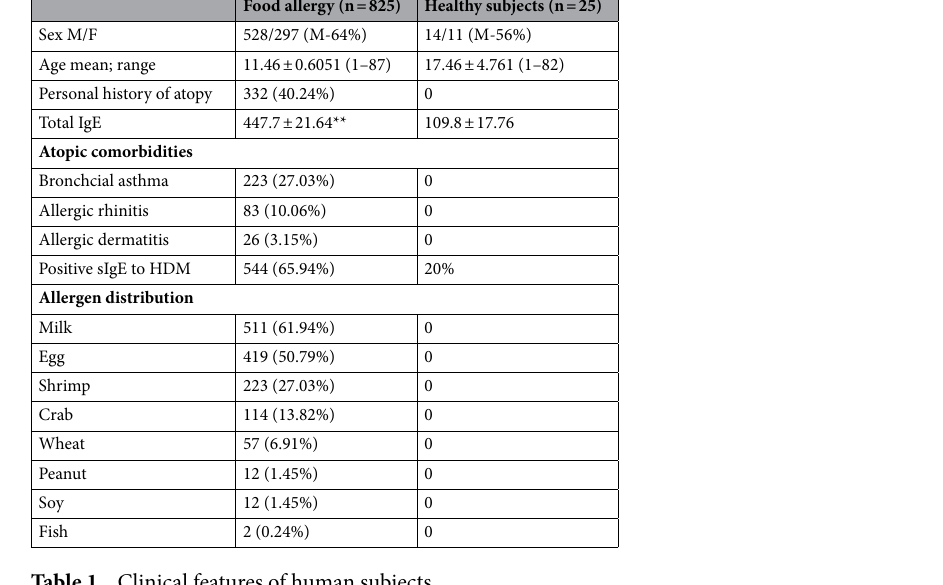
Table 1. Clinical features of human